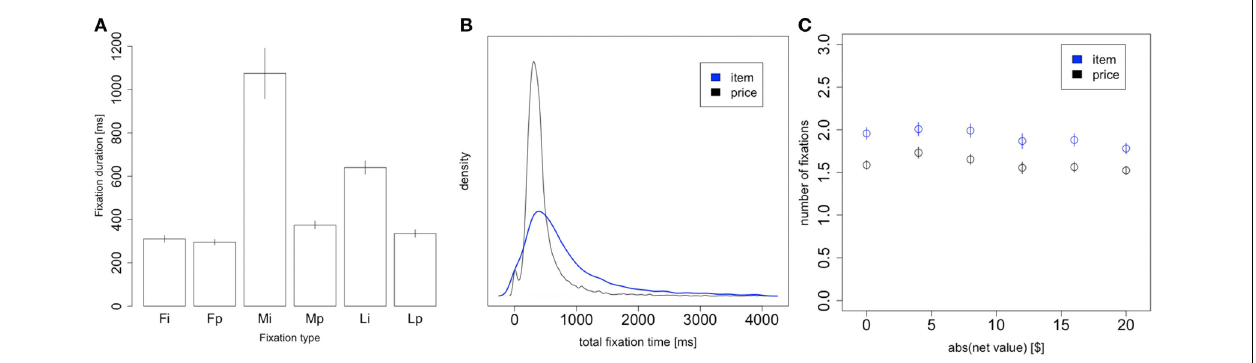
first/last fixation to each stimulus. (B) Density plot of the total trial time spent looking at the item (blue) and price (black). (C) The number of item and price fixations in a trial, as a function of the magnitude of the net value. Bars are standard error bars, clustered by